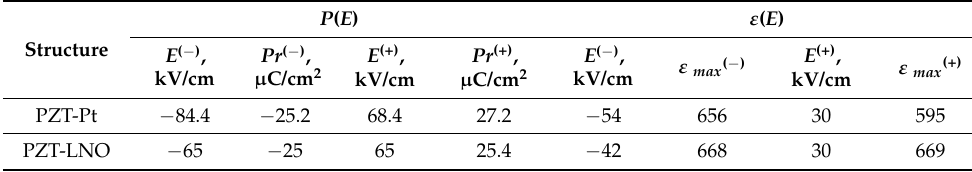
Table 2. Electrical data of PZT-Pt and PZT-LNO